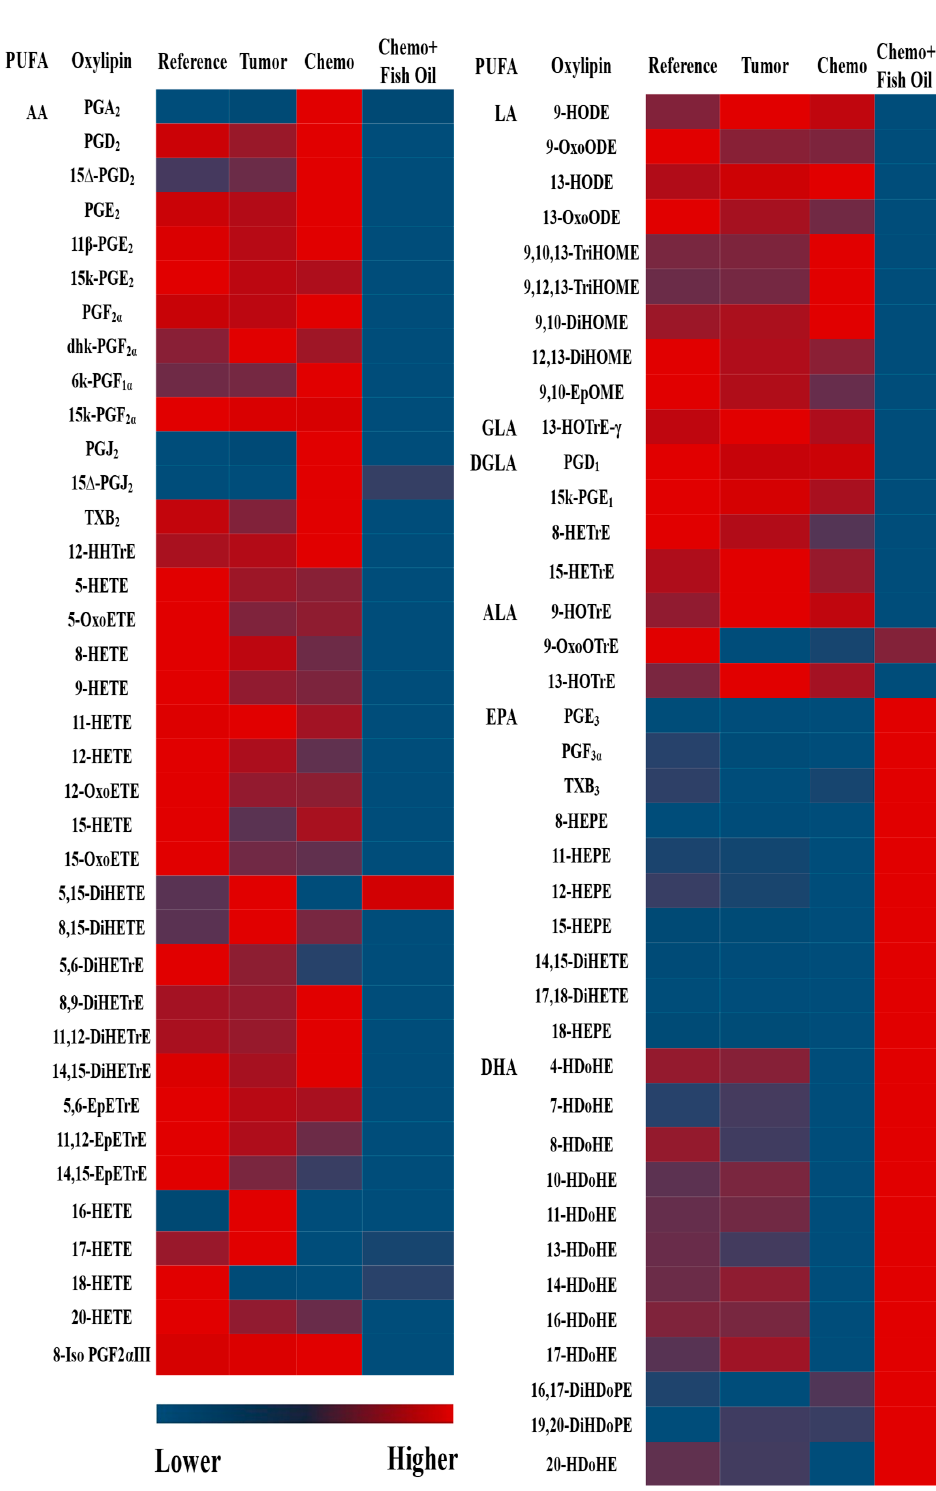
Figure 5. Heatmap of liver oxylipins showing the strong effects of dietary fish oil containing eicosa- pentaenoic acid (EPA) and docosahexaenoic acid (DHA). Groups: Reference, healthy rats that did not undergo tumor implantation nor receive chemotherapy, consumed control diet; Tumor, tumor- bearing animals that did not receive chemotherapy, consumed control diet; Chemo, tumor-bearing animals that received chemotherapy, consumed control diet; Chemo+Fish Oil, tumor-bearing animals that received chemotherapy, consumed fish oil diet, started same day as chemotherapy.